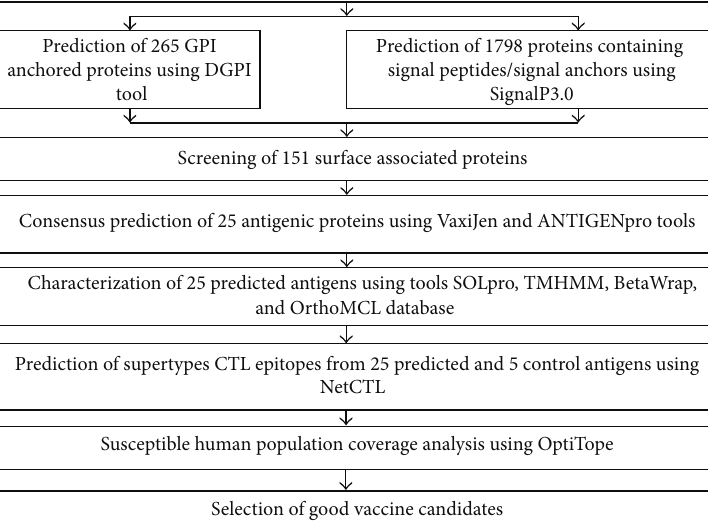
Additionally, Singh et al. [29, 30] also utilized the similar approach of MHC supertype based epitope identification, as a strategy to mine proteomic data for identification of novel CTL epitopes, in Plasmodium falciparum